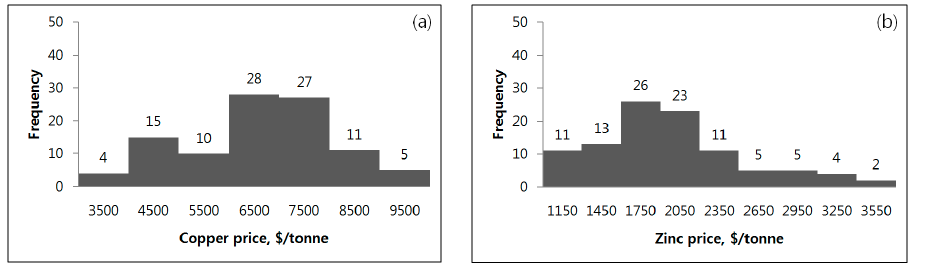
Figure 6. Results from Monte Carlo simulations. ( a ) Histogram of randomly extracted copper prices; ( b ) Histogram of randomly extracted zinc prices.